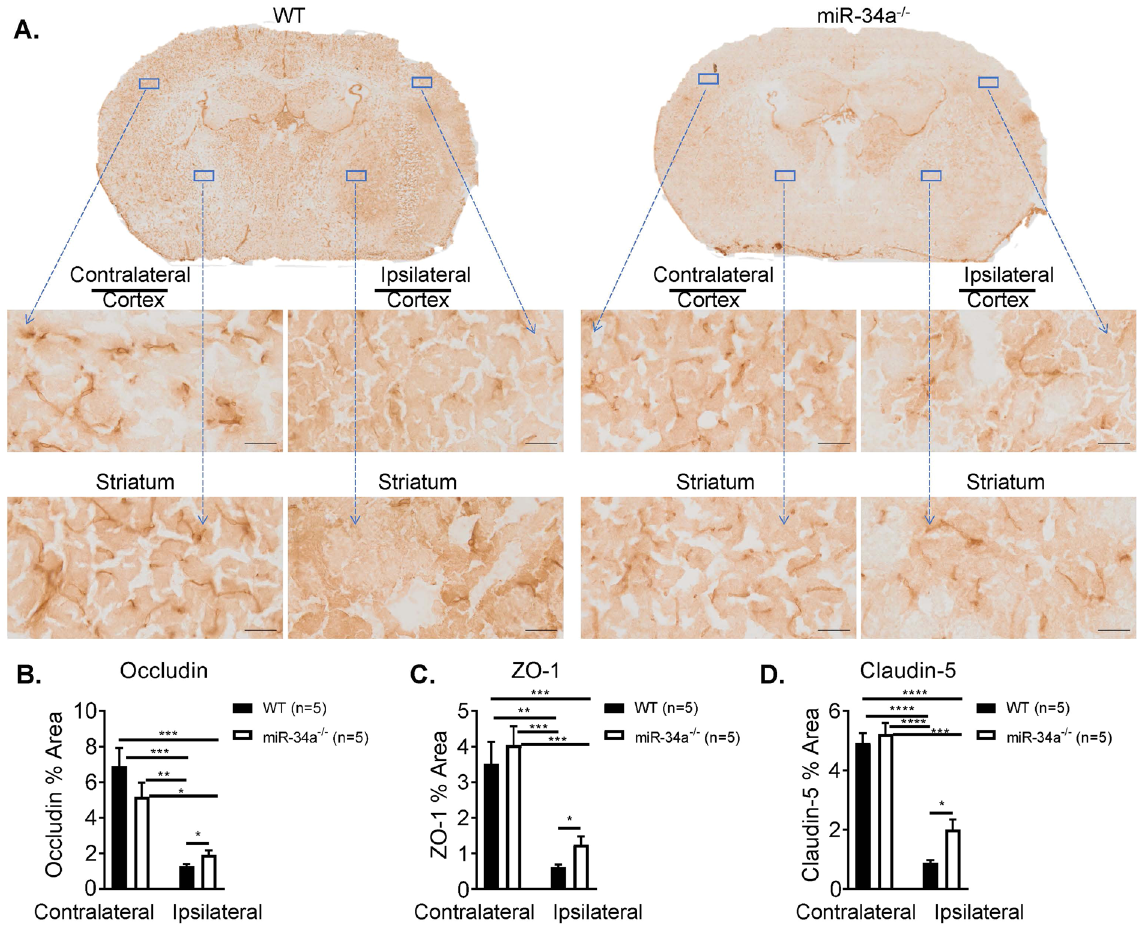
Figure 2. miR-34a depletion alleviates tight junction disruption following murine experimental stroke. Immunohistochemical staining of coronal cryosections of ischemic brains from WT and miR-34a − / − mice following 1 h tMCAO and 6 h reperfusion. ( A ) Representative images for Occludin immunoreactivity detected in both contralateral and ipsilateral hemispheres including cortex and striatum area. Scale bar = 100 µ m. Quantification of Occludin ( B ), ZO-1 ( C ), and Claudin-5 ( D ). **** p < 0.0001, *** p < 0.001, ** p < 0.01, * p < 0.05, n = 5 per group, and one-way ANOVA followed by post hoc Tukey’s test was used for data